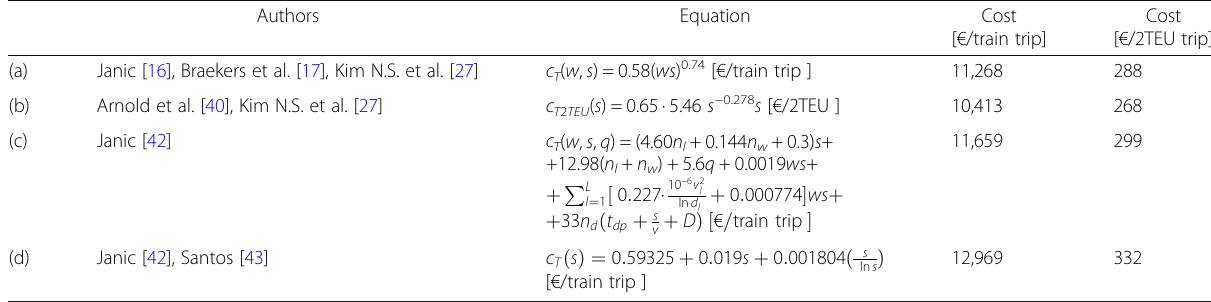
Table 1 Comparison of rail-haul costs using different equations on s = 400 km Authors Equation Cost